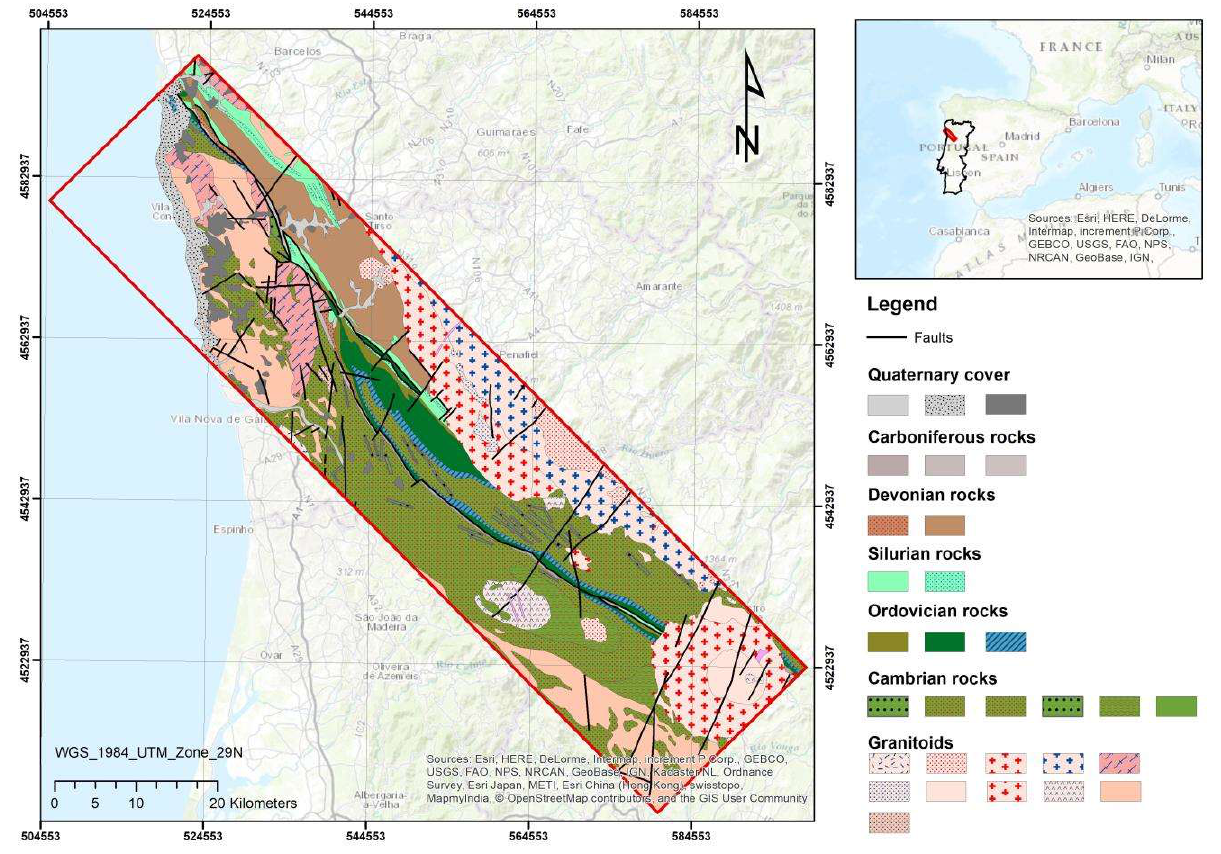
Figure 1. Valongo Mineral Belt [4,5].